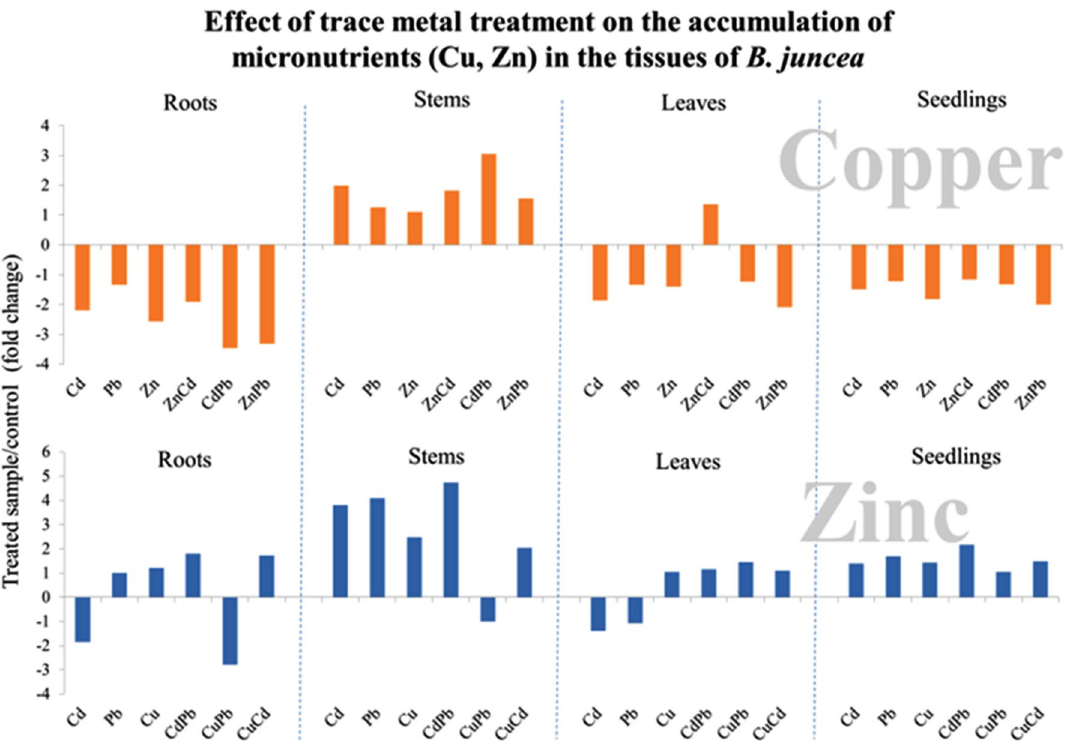
Figure 2. Accumulation of essential microelements: Cu, Zn in B. juncea v. Malopolska organs (roots, stems and leaves). Plants were grown in Hoagland’s medium and treated with bimetal combinations: CuPb, CuCd, CuZn, PbCd, PbZn, and ZnCd. Metal solutions Pb(NO 3 ) 2 , CuSO 4 , CdCl 2 , and ZnSO 4 were applied at a 25 μM concentration of each. Mean values of three replicates (±